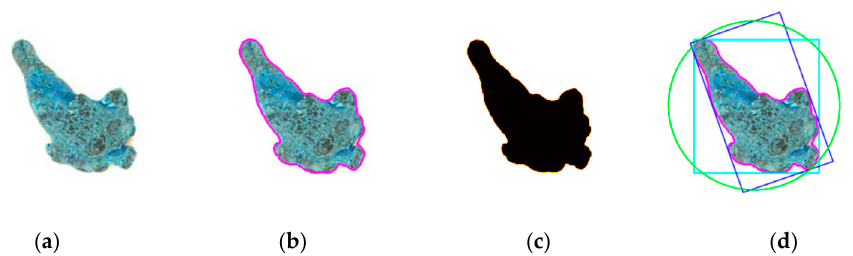
Figure 4. Shape feature extraction. ( a ) Gaussian filtered image, ( b ) perimeter extraction image, ( c ) area extraction image, ( d ) hybrid feature extraction image.